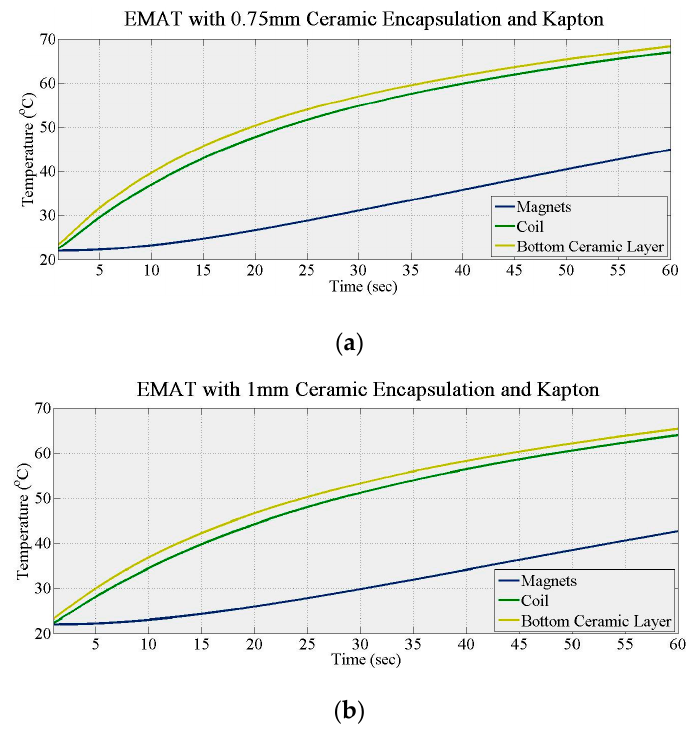
Figure 4. Temperature gradient of Kapton and alumina encapsulated coil ( a ) 0.75 mm alumina thickness; ( b ) 1 mm alumina thickness.